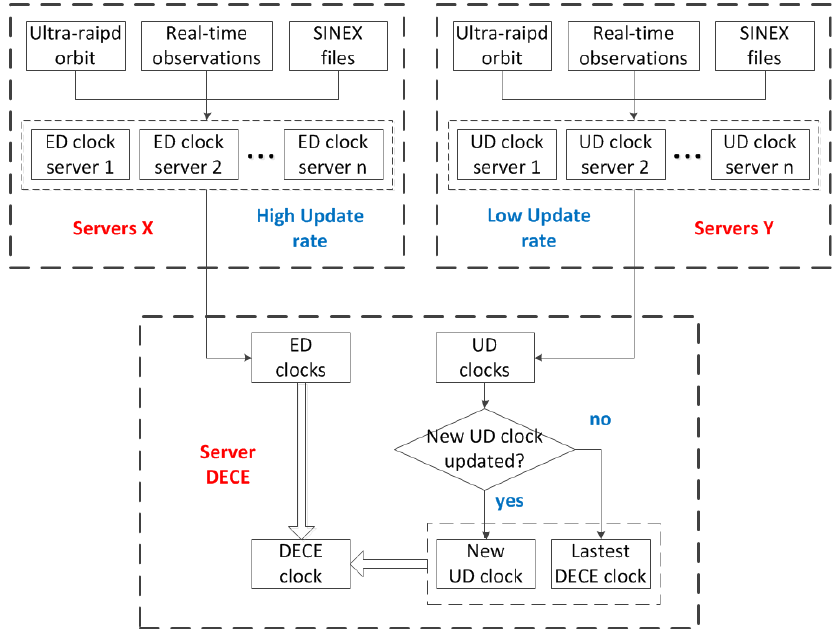
Figure 3. Flow chart of the decentralized clock estimation (DECE) with the basic configuration, i.e., one undifferenced (UD), one epoch-differenced (ED), and one combination process, each running in a server.